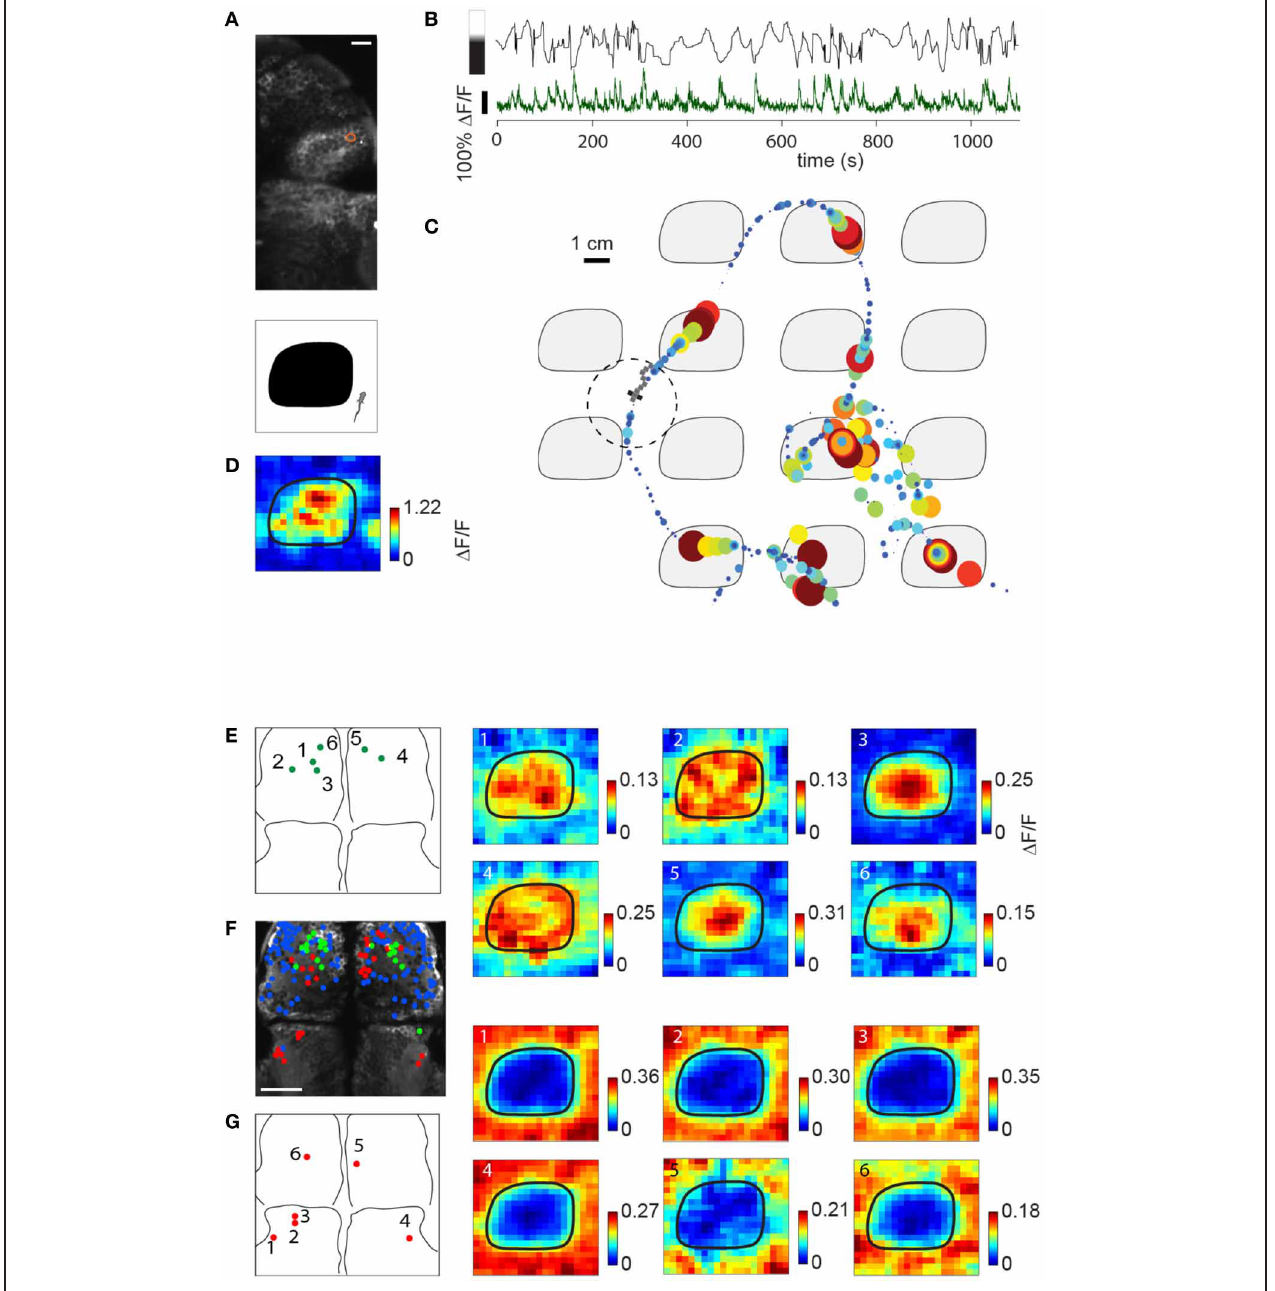
FIGURE 7 | Imaging sensory activity during fictive navigation. (A) Top: Two-photon image of right anterior midbrain and forebrain, with neuron displayed in (B–D) circled in red. Scale bar: 20um. Bottom: schematic of one tile of the virtual environment. (B) Activity of neuron outlined in (A) during fictive navigation of a transgenic elavl3:GCaMP5 fish expressing a genetically-encoded calcium indicator in almost all neurons. Top: Distance from the center of the nearest dark patch, with bar on the left indicating approximate brightness. Bottom: (cid:2) F/F. Peaks in (cid:2) F/F coincide with approaches to the center of a dark patch. (C) Neural activity overlaid on the path through the virtual environment. Activity is represented by size and color, with largest discs corresponding to (cid:2) F/F = 1. Seven minutes of the experiment are shown. (D) Neural activity averaged over the entire trajectory, averaged over one tile. This activity pattern is consistent with a neuron